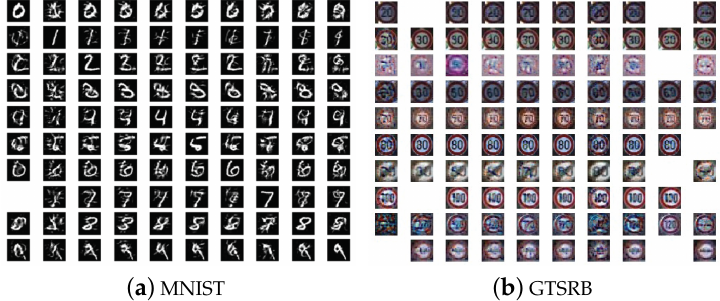
Figure 5. Final adversarial examples of our attacks. The diagonal contains the original images, and for every column image; they are classified into the same target class but the vision stays like the original image. The empty area indicates the failure of transferable adversarial